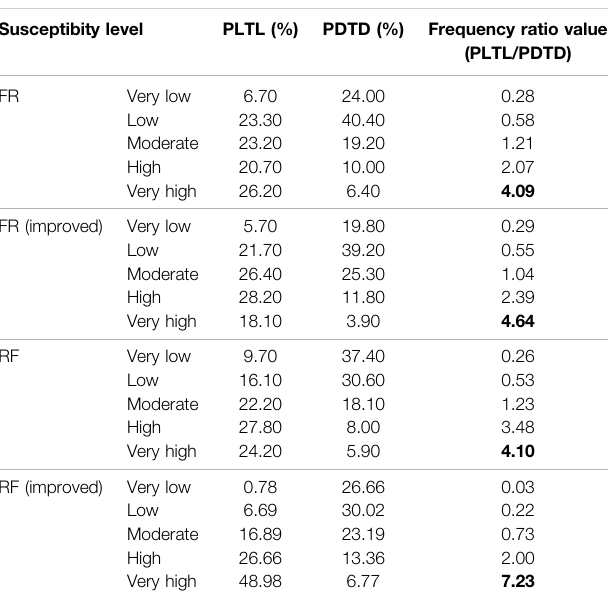
TABLE 8 | Accuracy statistics for each suscepbitity level.